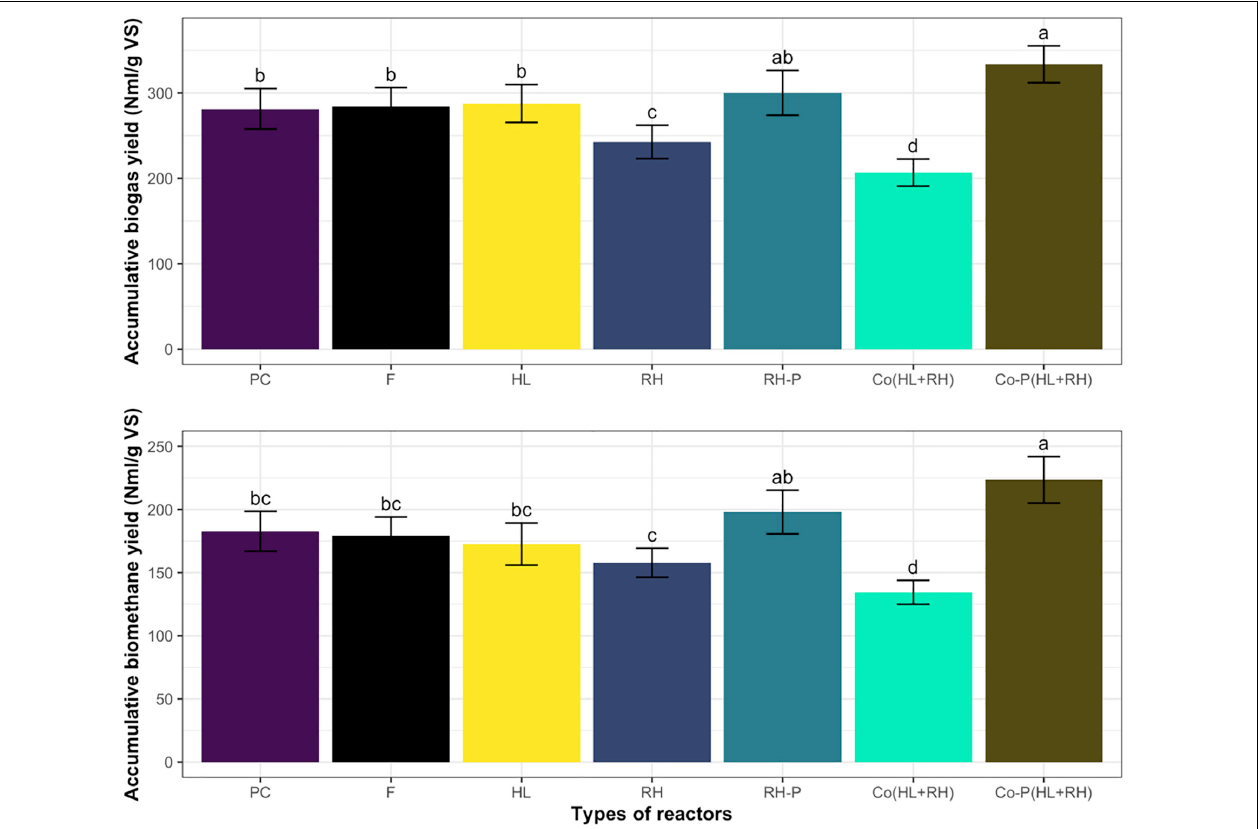
FIGURE 1 | (A) Accumulative biogas yield of PC (positive control containing cellulose), F (feathers), HL (feathers hydrolysate), RH (rice husk), RH-P (rice husk pretreated), Co (HL+RH) [co-digestion (hydrolysate + rice husk)], Co-P (HL+RH) [co-digestion with pretreated (hydrolysate + rice husk)]. Means having the same letter are statistically similar as per the Tukey test at p < 0.05. (B) Accumulative biomethane yield from PC (positive control containing cellulose), F (feathers), HL (feathers hydrolysate), RH (rice husk), RH-P (rice husk pretreated), Co (HL+RH) [co-digestion (hydrolysate + rice husk)], Co-P (HL+RH) [co-digestion with pretreated (hydrolysate + rice husk)]. Means having the same letter are statistically similar as per the Tukey test at p <